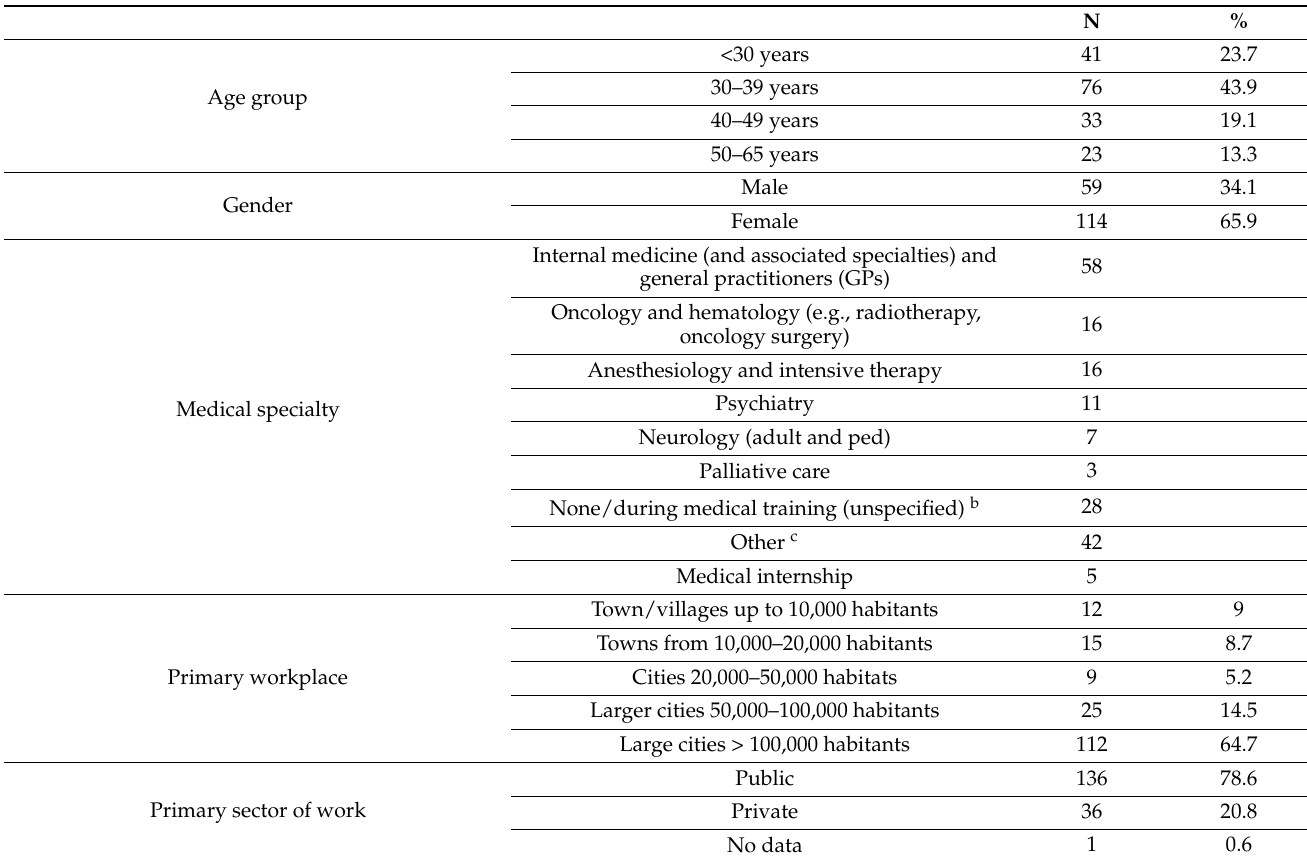
Table 1. Study participant’s